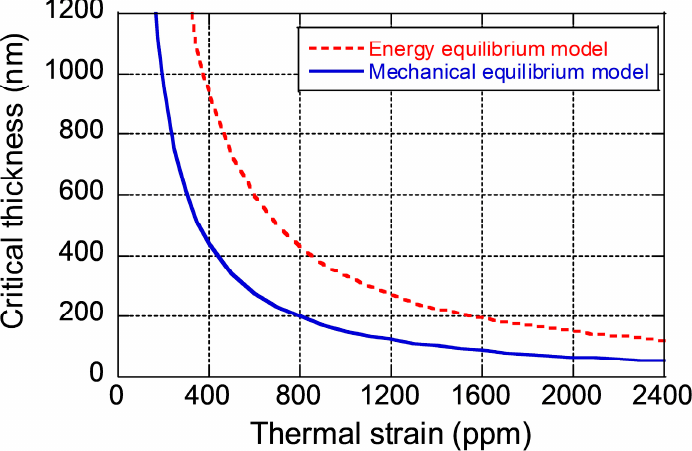
Figure 2. Strain dependence on calculated critical thickness of indium phosphide (InP) directly bonded on Si.